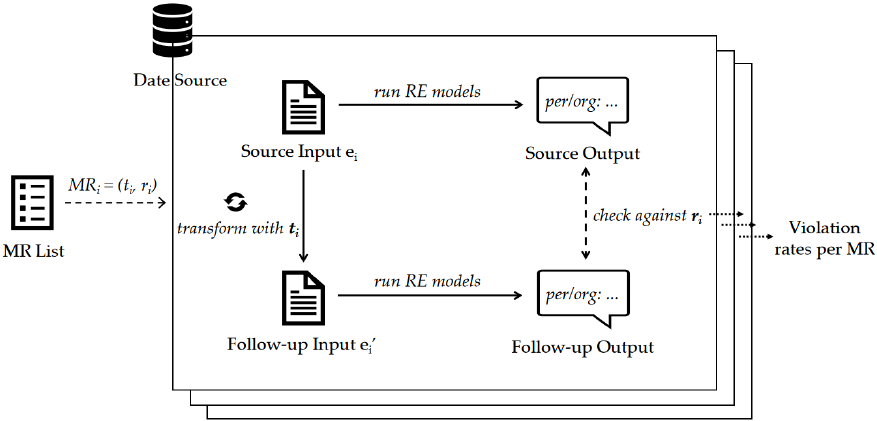
Figure 2. Overview of how metamorphic testing (MT) is applied to evaluate RE models. Table 1. Transformation operation and output relationship of